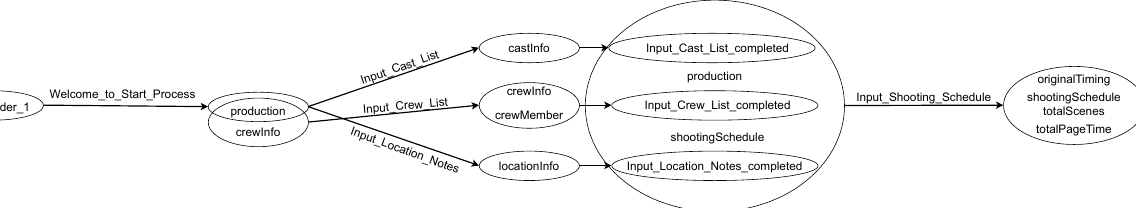
Figure 11. Film production process represented with a metagraph. Only the start of the YAWL process is represented for brevity. The task Input Cast List does not share variables with its next task, Input Shooting Schedule , thus we add a proposition indicating the completion of the